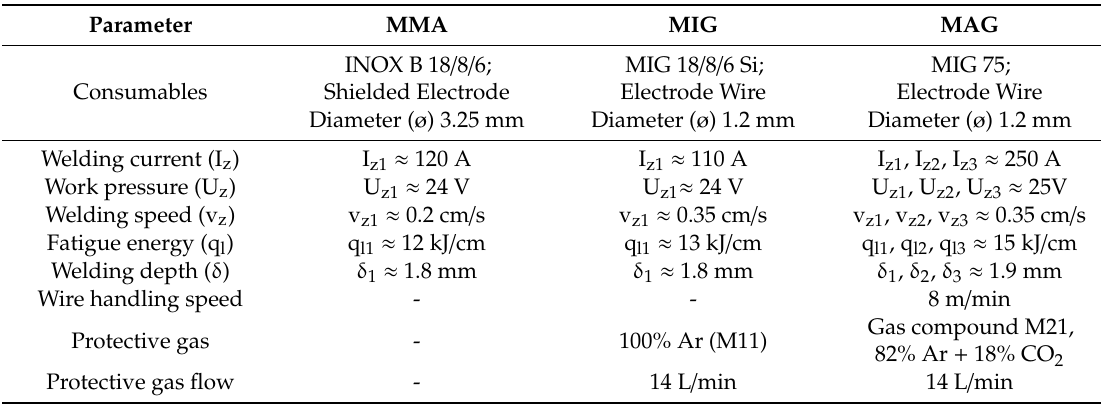
Table 2. Welding parameters and related consumables.